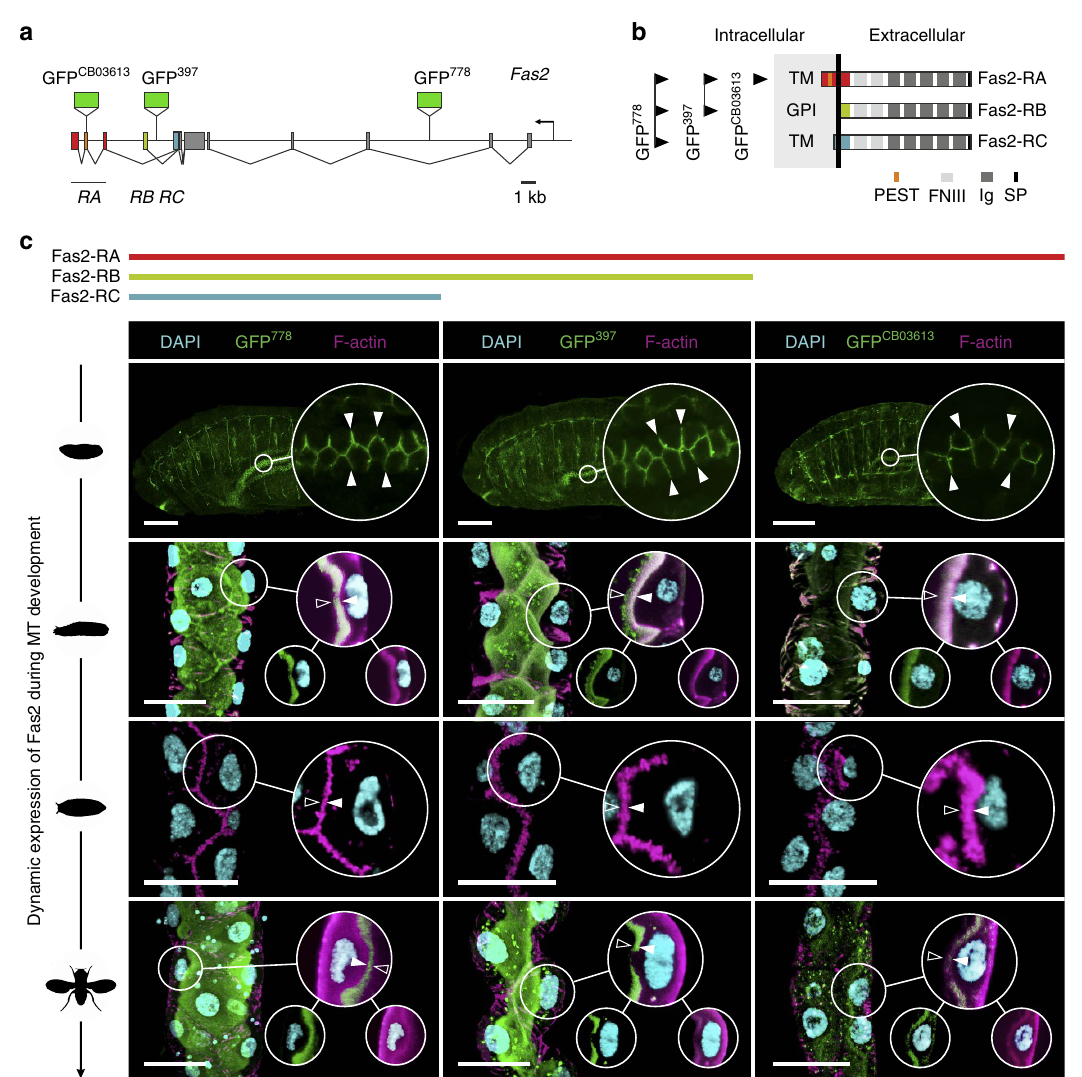
Figure 2 | Fas2 is dynamically expressed during tubule development. ( a ) Fas2 genomic region illustrating the positions of the GFP CB03613 , GFP 397 and GFP 778 exon trap insertions. ( b ) Fas2 is expressed in multiple isoforms that all comprise five immunoglobulin (Ig) and two fibronectin type III (FNIII) domains, yet have distinct C-termini. Arrows indicate splice variants recognized by each exon trap insertion line. The differences between transcripts Fas2-RA, -RB and -RC are highlighted in a , b using the same colour code. PEST, PESTdomain; SP, signal peptide. ( c ) In stage 16 embryos, Fas2 localizes to cell junctions of the developing MTs; however, Fas2 switches abruptly to the apical brush border prior to eclosion of the first instar larva, where it remains throughout larval development. As the third instar larva pupates, the MTs become transport incompetent, the microvilli shorten, tubule lumen is reduced and Fas2 is no longer expressed. As the brush border reform in the adult tubule, Fas2 is again abundantly expressed in the MT, where it localizes to the apical brush border (area between arrows). This expression pattern is consistently reported by each fusion protein, and is commensurate with the transcription profile of each Fas2 isoform. Inserts: single optical section of the selected region shown as separate (small circle) and merged (large circle) signals. Scale bars, 25 m